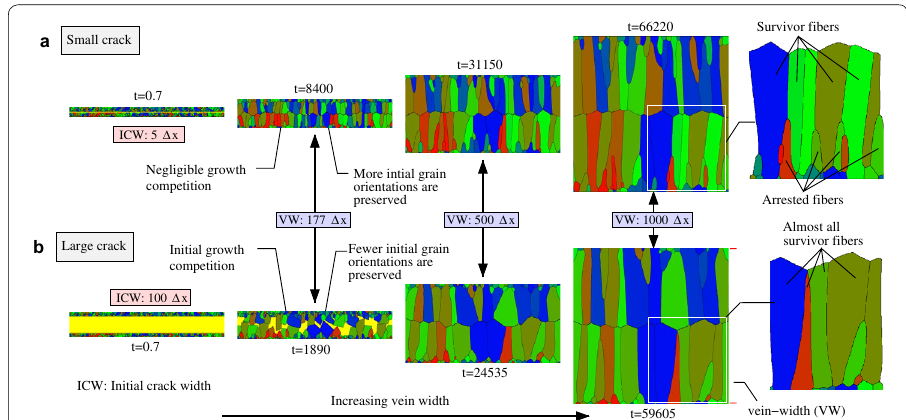
5 (cid:31) x (small crack) and b initial crack width =